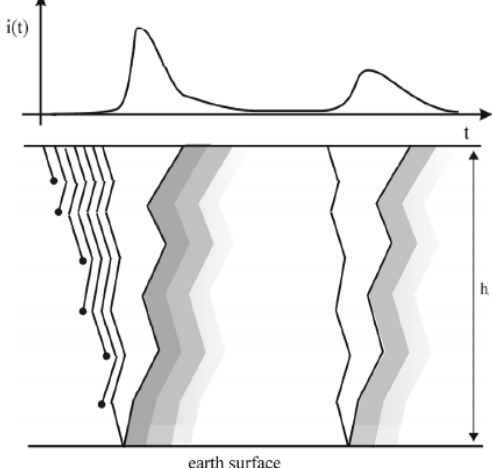
Figure 2. Lightning strike development through time t . Table 1. Logarithmic normal distribution of lightning current parameters